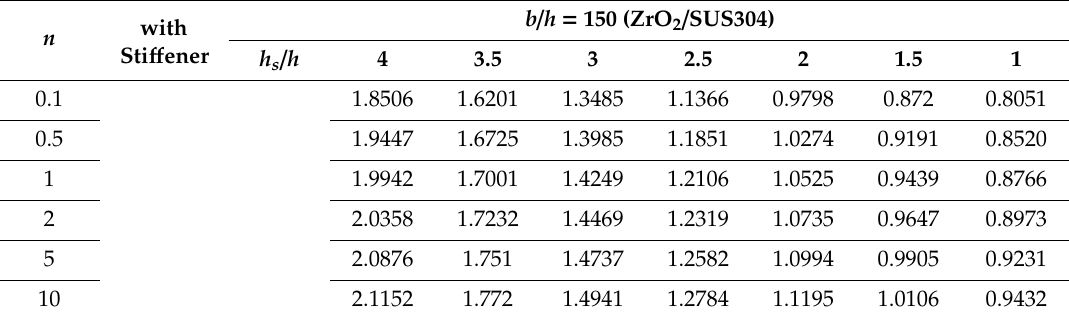
Table 13. Buckling coe ffi cient of FGM plate with and without a central sti ff ener (ZrO 2 / SUS304, b / h = 150).